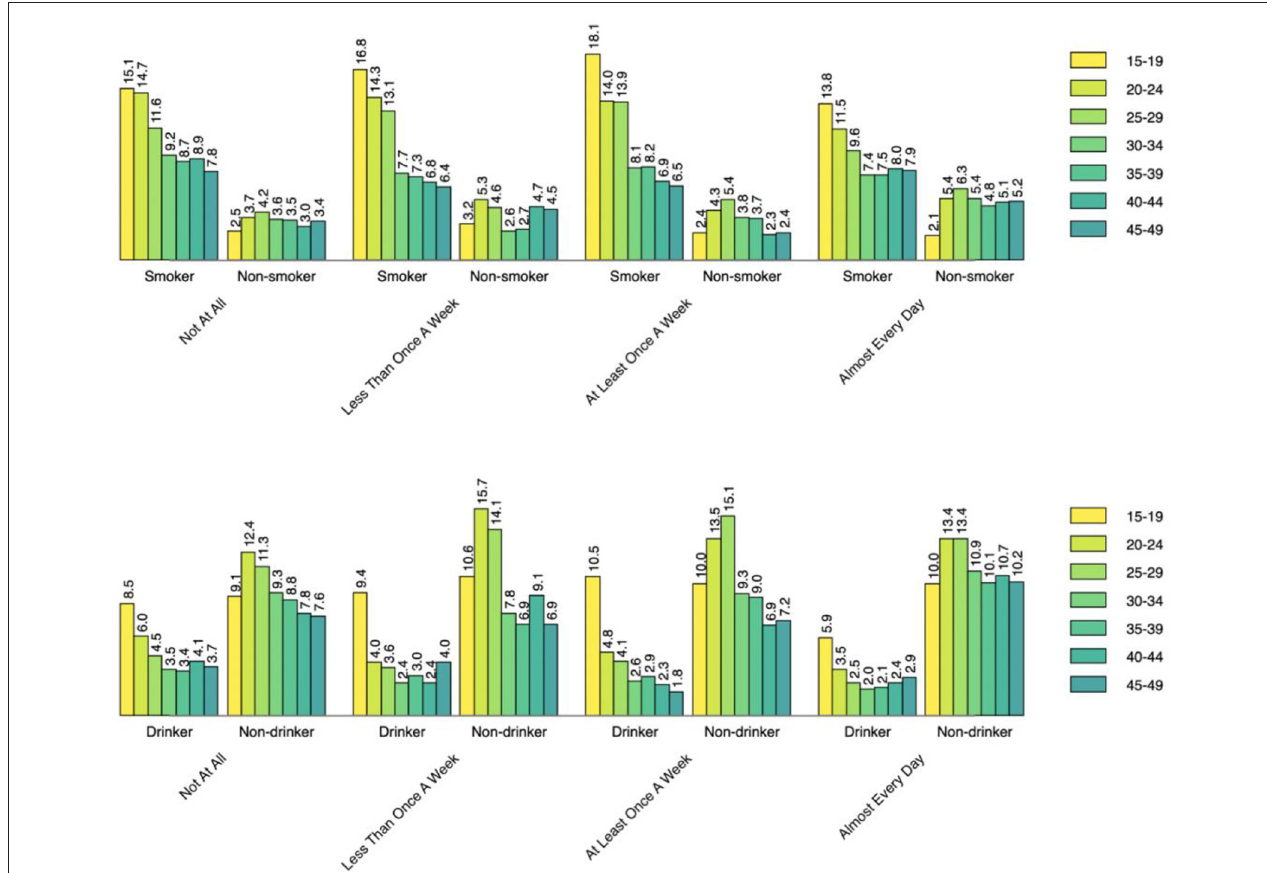
FIGURE 3 | Smoking status across the age groups by radio use status.